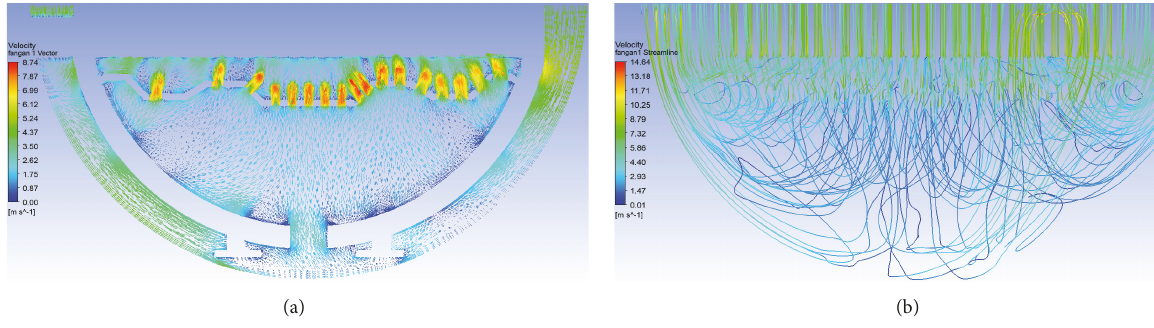
Figure 12: Flow field analysis in the lower plenum. (a) Velocity vector diagram. (b) Streamlines